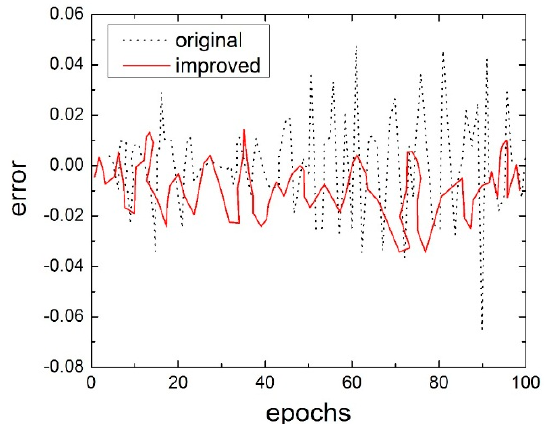
Figure 10. Fitting-error-rate curve. “Original” and “improved” represent the fitting-error-rate curve of the BP artificial neural network and BP artificial neural network based on genetic algorithms, respectively.